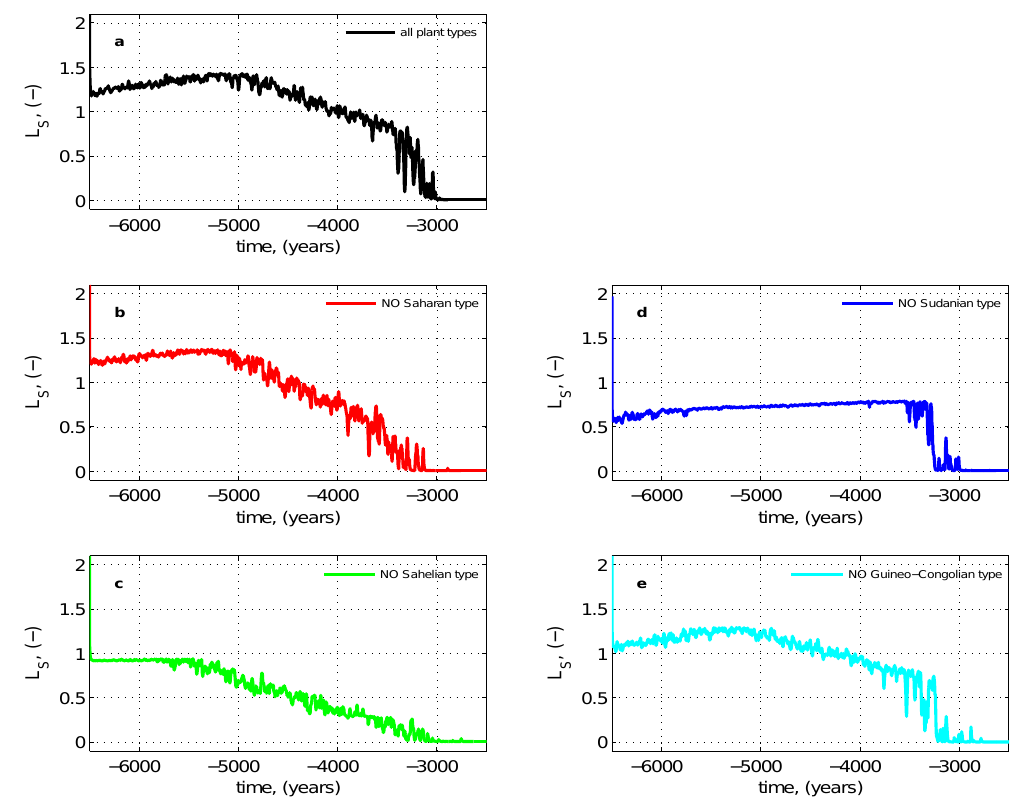
Figure 4. Transient dynamics of mean effective leaf area L S illustrate the impact of the removal of plant types. Panels (a–e) show 100 year running means of different simulation set ups. The mean effective leaf area L S accounting for all plant types ( N = n = 4 in Eq. 10) is shown as a reference (a) . In each of the other simulations, one niche is not occupied ( N = 3 and n = 4 in Eq. 10): no Saharan type (b) , no Sahelian type (c) , no Sudanian type (d) or no Guineo–Congolian type (e)